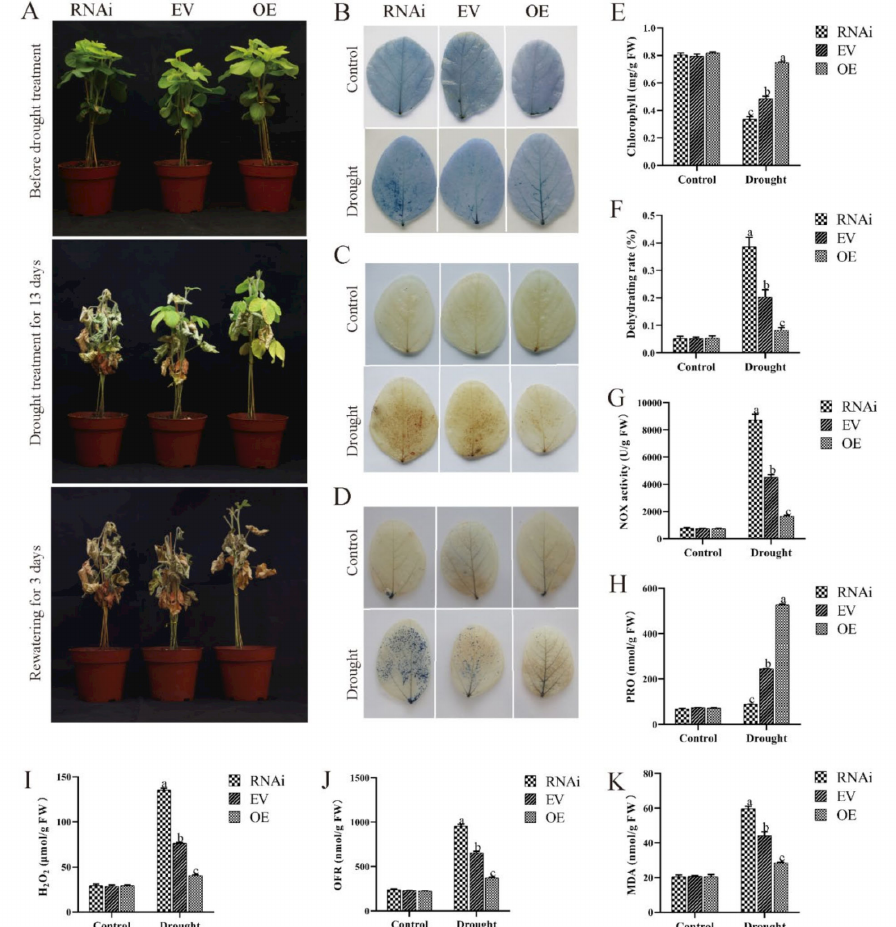
Figure 8. Under drought treatment, the phenotype of hairy root soybean, the states of difference hairy root plant leaves and the results of physiological index. ( A ) the seedlings with 2–5 cm hairy roots were grown for five days in pots under non-drought conditions, and then watering was withheld from plants for 13 days. Survival rates of the water-stressed plants were determined three days after rewatering. ( B ) Trypan blue staining of dead cells (live cells do not stain) of the hairy root soybean plant leaves without irrigation for 11 days. DAB ( C ) and NBT ( D ) staining of the hairy root soybean plant leaves of OE, EV and RNAi after drought or non-drought treatment for a week. The depth of color shows the concentrations of H 2 O 2 and O 2 − in the leaves. Chlorophyll content ( E ), water-loss rate ( F ), NOX content ( G ) proline content ( H ), H 2 O 2 content ( I